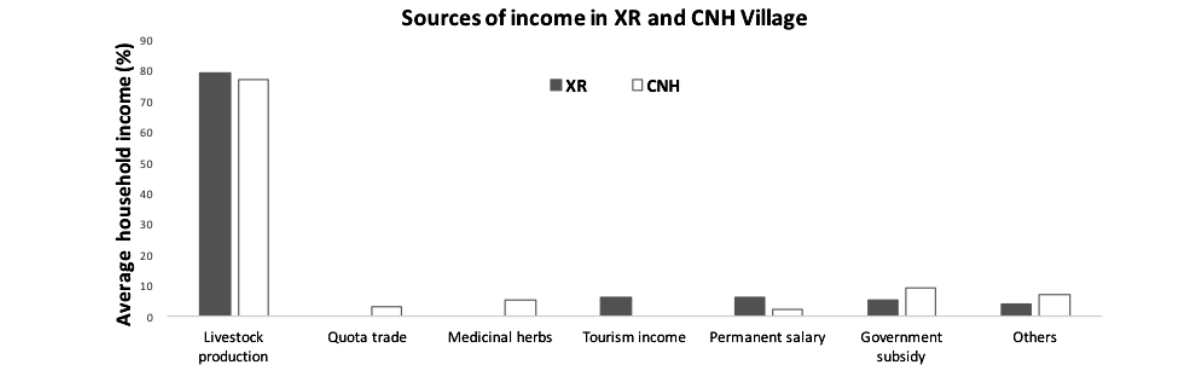
Fig. 2 . Sources of household income in XR and CNH Villages in